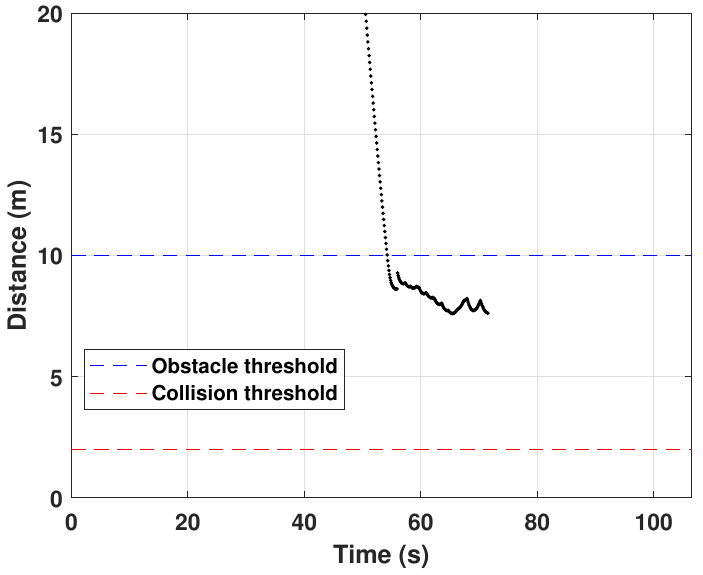
Figure 11. Case 2: Quadcopter’s trajectory.